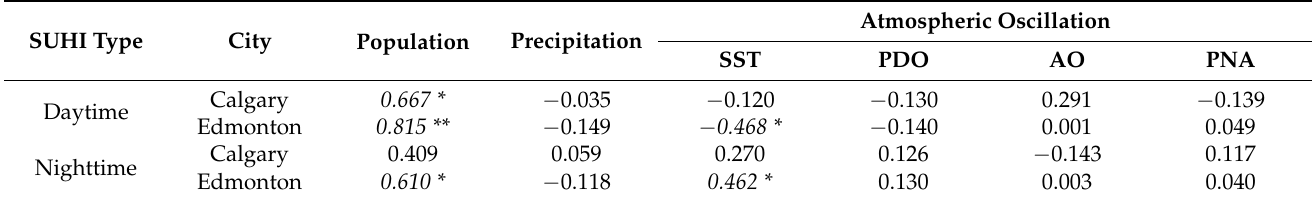
Table 2. Pearson correlation coefficients for annual day and nighttime SUHI against the influencing factors in the cities of Calgary and Edmonton during 2001–2020. The significant values are in italics, where * and ** indicate the 95 and 99% confidence levels,